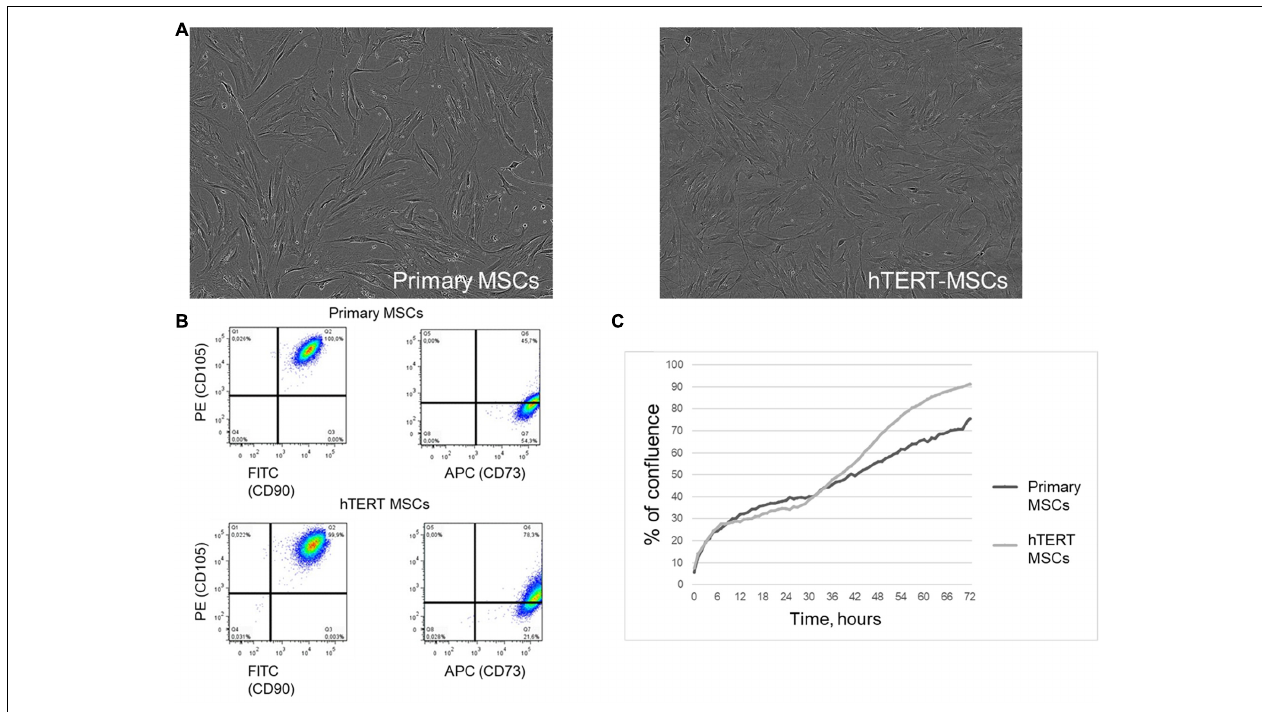
FIGURE 1 | Human adipose-derived primary MSCs and hTERT-MSCs share similar morphology and immunophenotype characteristics of multipotent MSCs. (A) Morphology of cultivated MSCs and hTERT-MSCs, phase contrast microscopy, magn. × 200. (B) Evaluation of MSC markers by flow cytometry. More than 99% of MSCs express CD73, CD90, and CD105. (C) Proliferation curves of primary MSCs and hTERT-MSCs over a 72-h time-lapse in IncucyteZOOM. Presented data refer to the n = 8 independent experiments on primary MSCs from four different